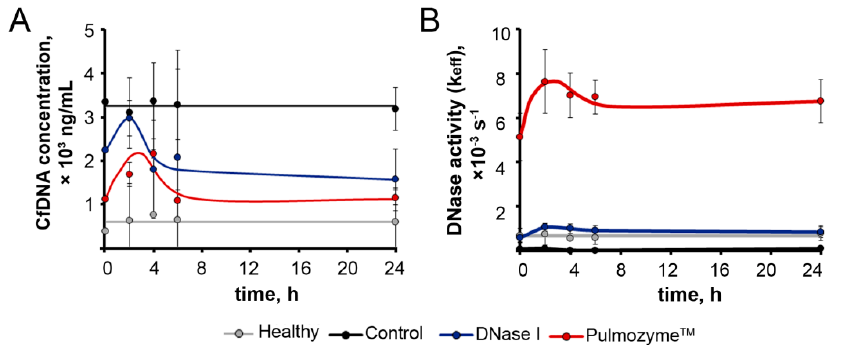
Figure 5. The one-day dynamic of cfDNA concentration and DNase activity in blood serum of mice with metastatic B16 after the i.n. treatment with Pulmozyme ® or DNase I: summary data. ( A ) cfDNA concentration. ( B ) DNase activity. Treatment scheme is presented in Figure 3A. On day 15 after B16 implantation, the fourth i.n. administration of saline buffer (control), Pulmozyme ® and DNase I to mice with B16 was performed; after 0, 2, 4, 6 and 24 h, blood samples were collected, and cfDNA and DNase activity in blood serum was measured. Data are presented as mean ± SE. Healthy group is marked in grey, control group—black, DNase I group—blue, Pulmozyme ®